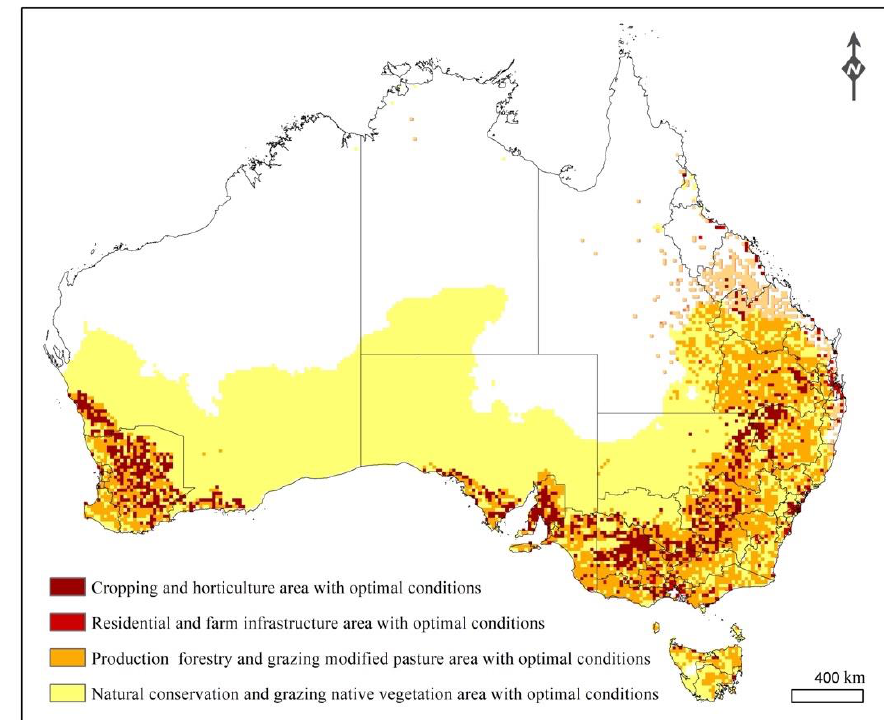
Figure 5. Potential areas in Australia at risk for invasion identified by spatial overlay analysis of predicted climate suitability for tomato potato psyllid (TPP) and Candidatus Liberibacter solanacearum (CLso) and national scale land use data.